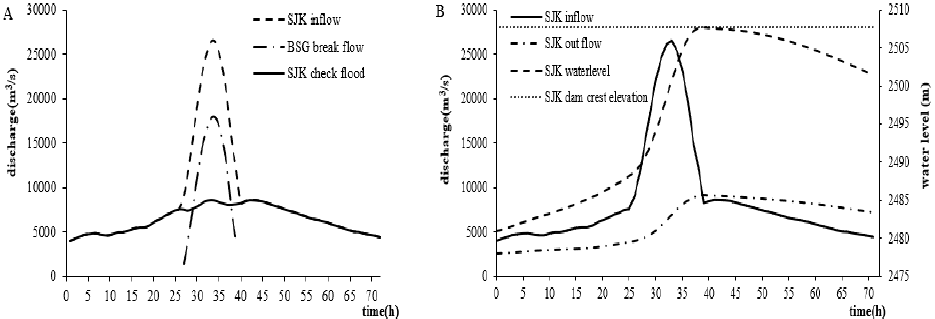
Figure 13. ( A ) The BSG break flood encounters SJK check flood; ( B ) the regulated flood progress of